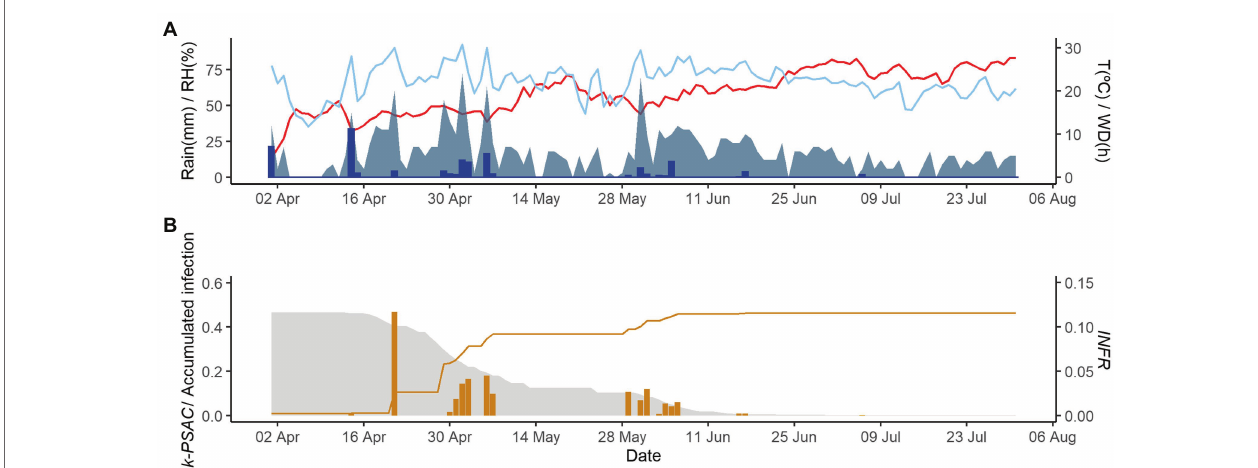
FIGURE 4 | Model output of PCLS for the vineyard in Godijne in 2020. (A) Weather variables: air temperature (T, red line in ° C), rain (blue bars in millimeters), leaf wetness duration (WD, light blue area in hours), and relative humidity (RH, blue line in %). (B) Inoculum dose as k - MATR (gray area), daily values of predicted infection (orange bars; average value of INFR L and INFR S ), and accumulated infection during the season (orange